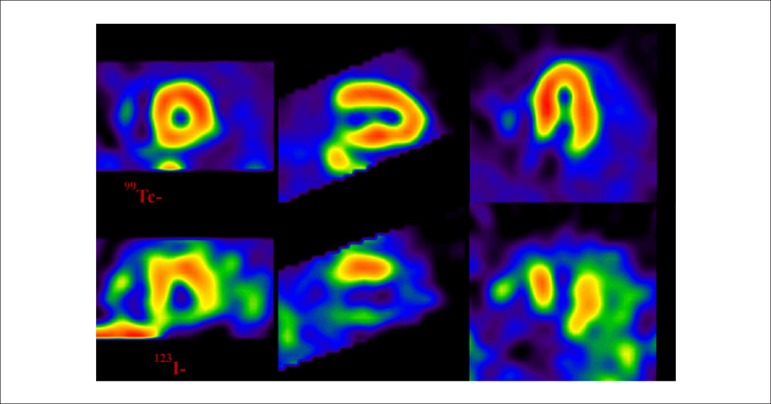
Patient with acute coronary syndrome (ACS). Normal myocardial perfusion scintigraphy (MPS) with Sestamibi-99mTc (top row). Myocardial scintigraphy (MS) with MIBG-123I (bottom row) demonstrates uptake defects in apical segments, suggestive of Takotsubo syndrome. Reduced tracer uptake is additionally observed in the inferior wall.